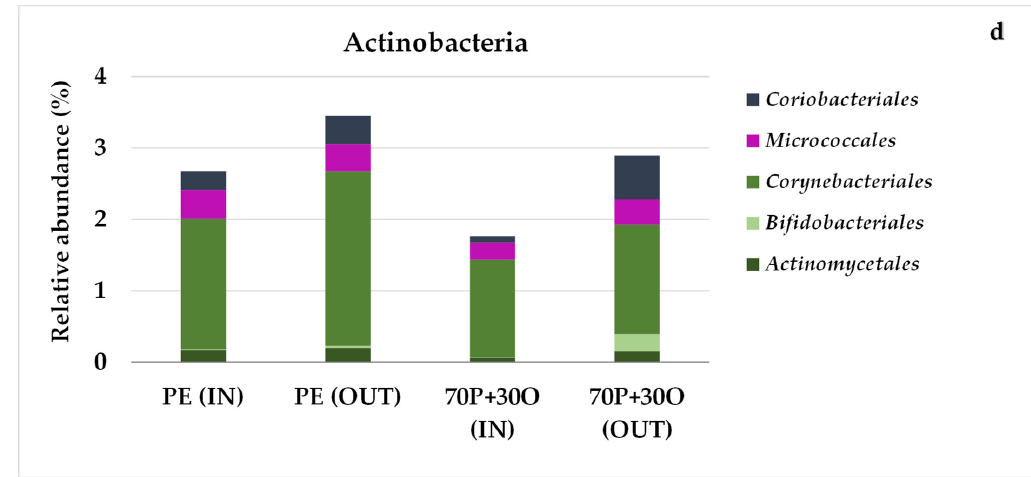
Figure 4. Relative abundances of orders ( a ) Firmicutes ( b ) Bacteroidetes, ( c ) α -Proteobacteria, β -Proteobacteria, δ -Proteobacteria, and γ -Proteobacteria, and ( d ) Actinobacteria composition in samples from anaerobic digestion experiments. The abundance is presented in terms of a percentage of the total number of sequences in a sample.